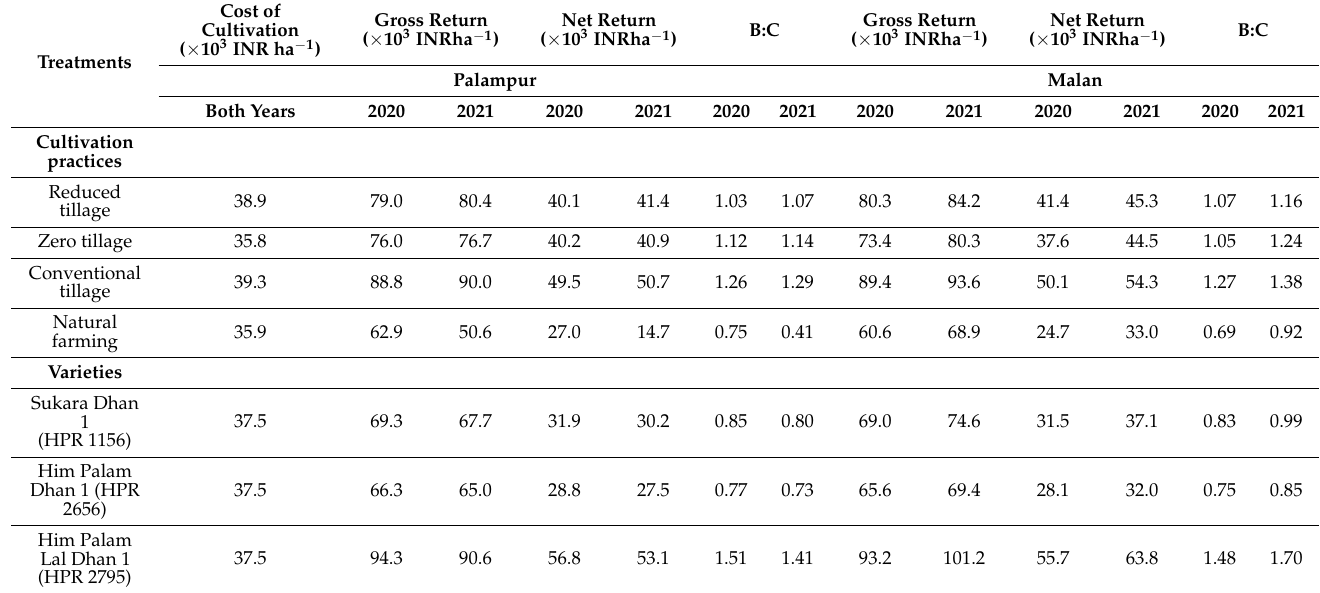
Table 4. Effect of cultivation practices on the profitability of different rice varieties at Palampur and